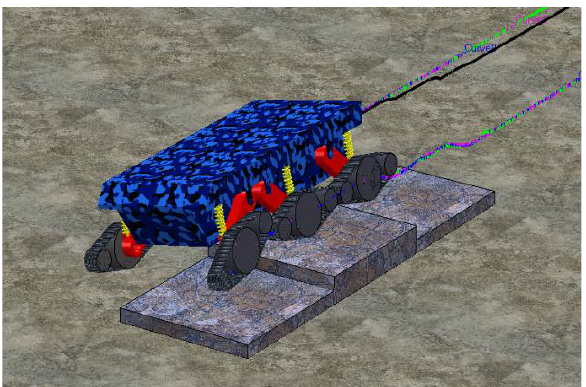
Figure 8. Six-track robot traverses a single-sided step scenario, which consists of four steps with height of 0.2 m, where only one side of the tracked robot is allowed to pass.